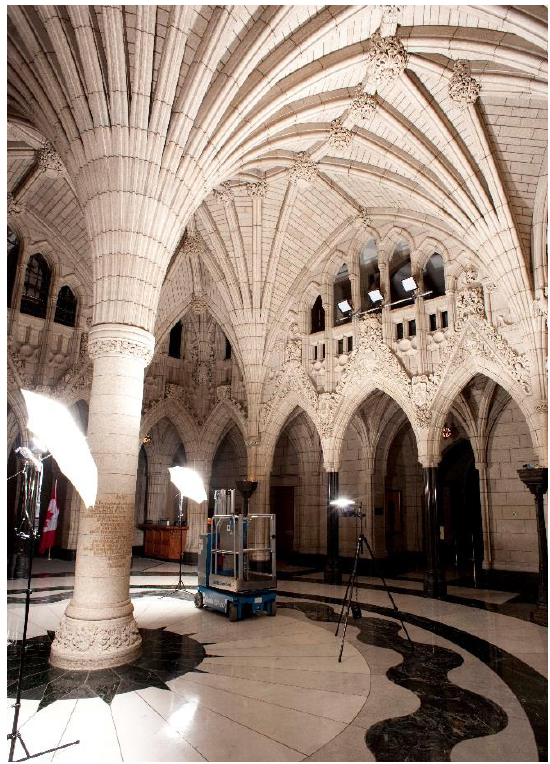
Figure 6: Confederation Hall, also known as the Rotunda shown below with flash setup (HCS, 2017).